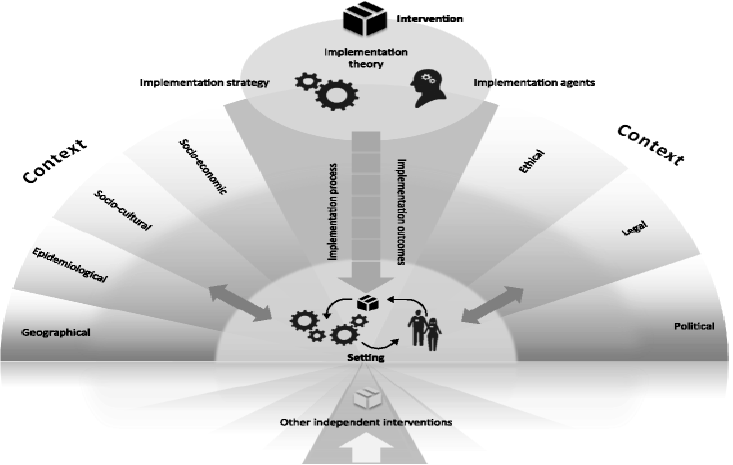
Figure 2. The Context and Implementation of Complex Interventions (CICI) framework. Reproduced with permission from [18], [Implementation Science]; published by [Springer Nature], [2017].